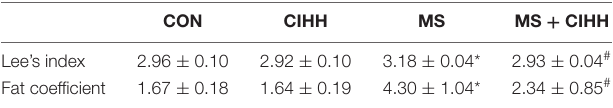
TABLE 1 | Effect of CIHH on Lee’s index and fat